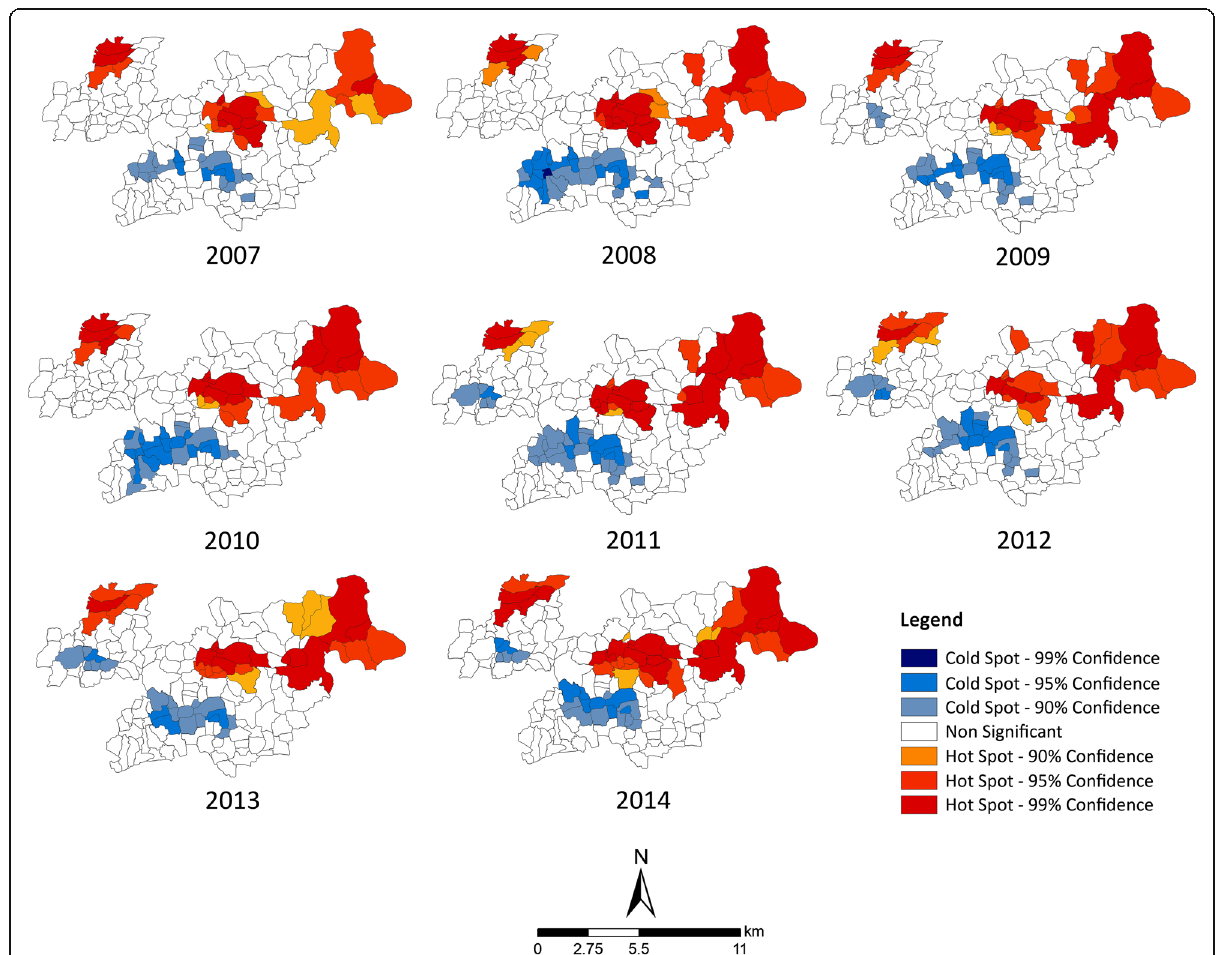
Fig. 3 Spatial and temporal distribution of hot and cold spots in the study area